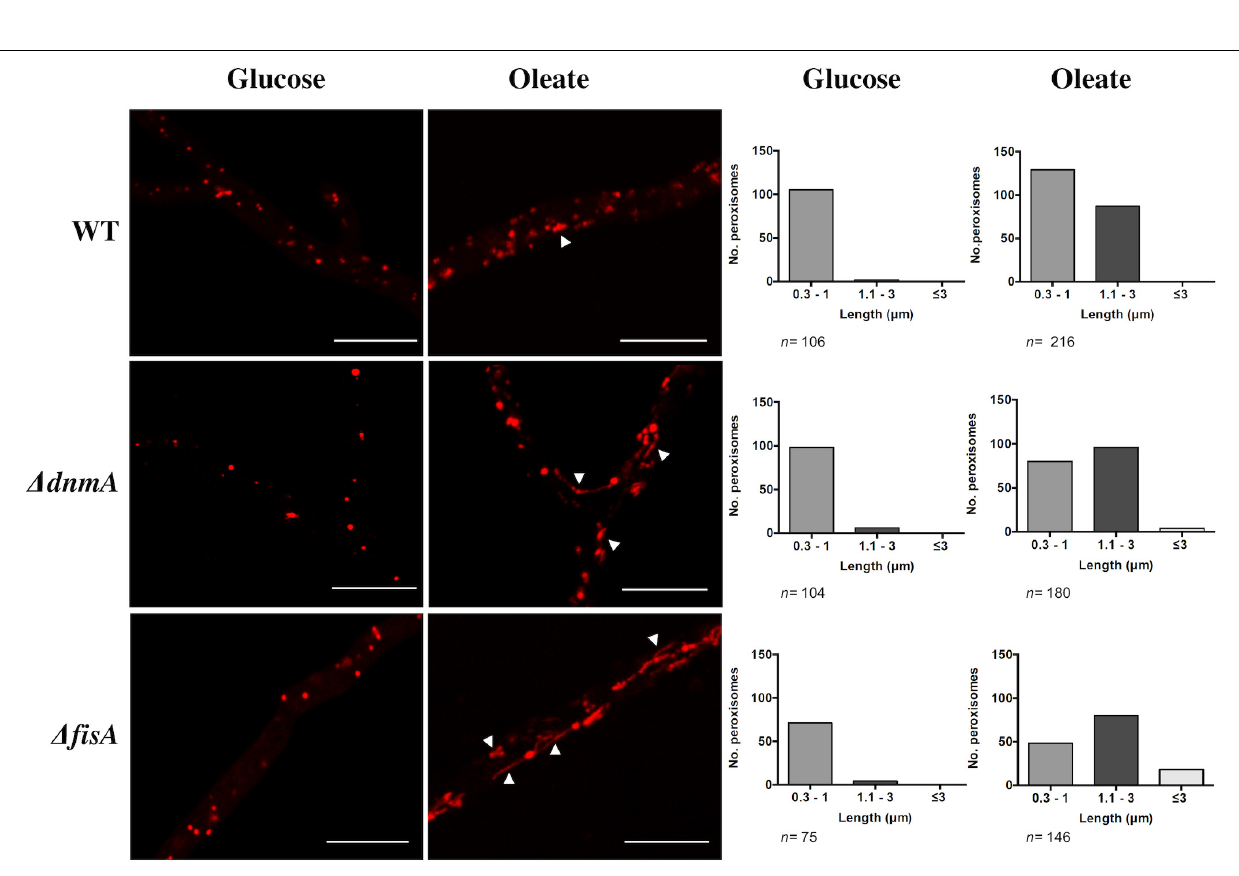
Frontiers in Microbiology |